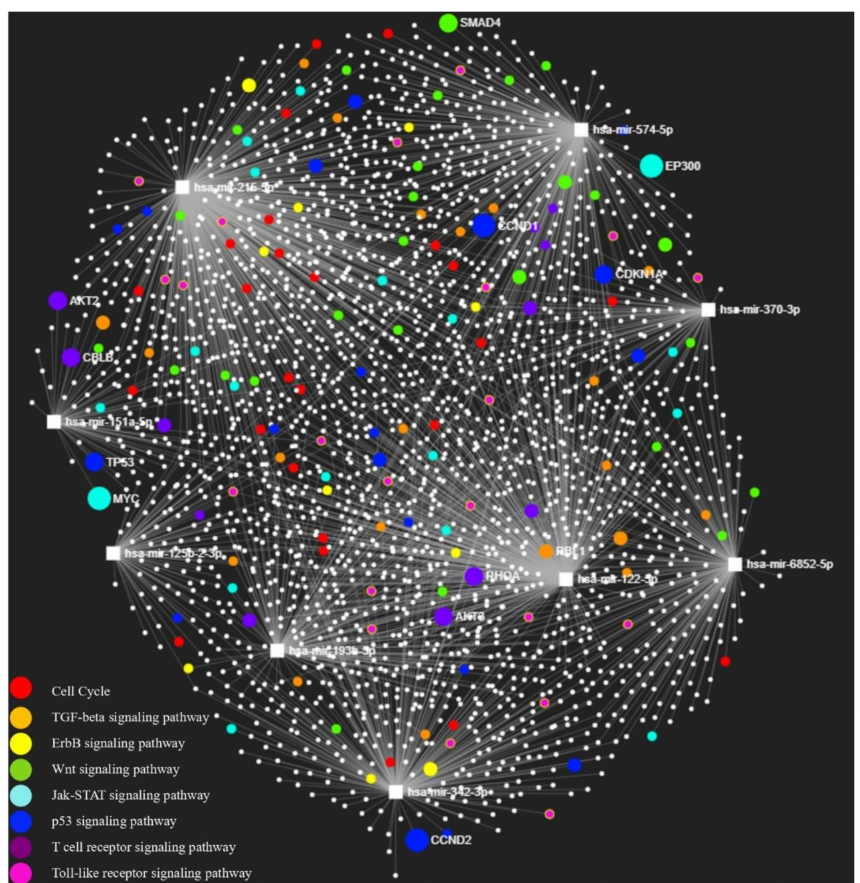
Figure 2. Network of 9 validated miRNAs and target genes. Squares denote miRNAs and circles denote target genes.